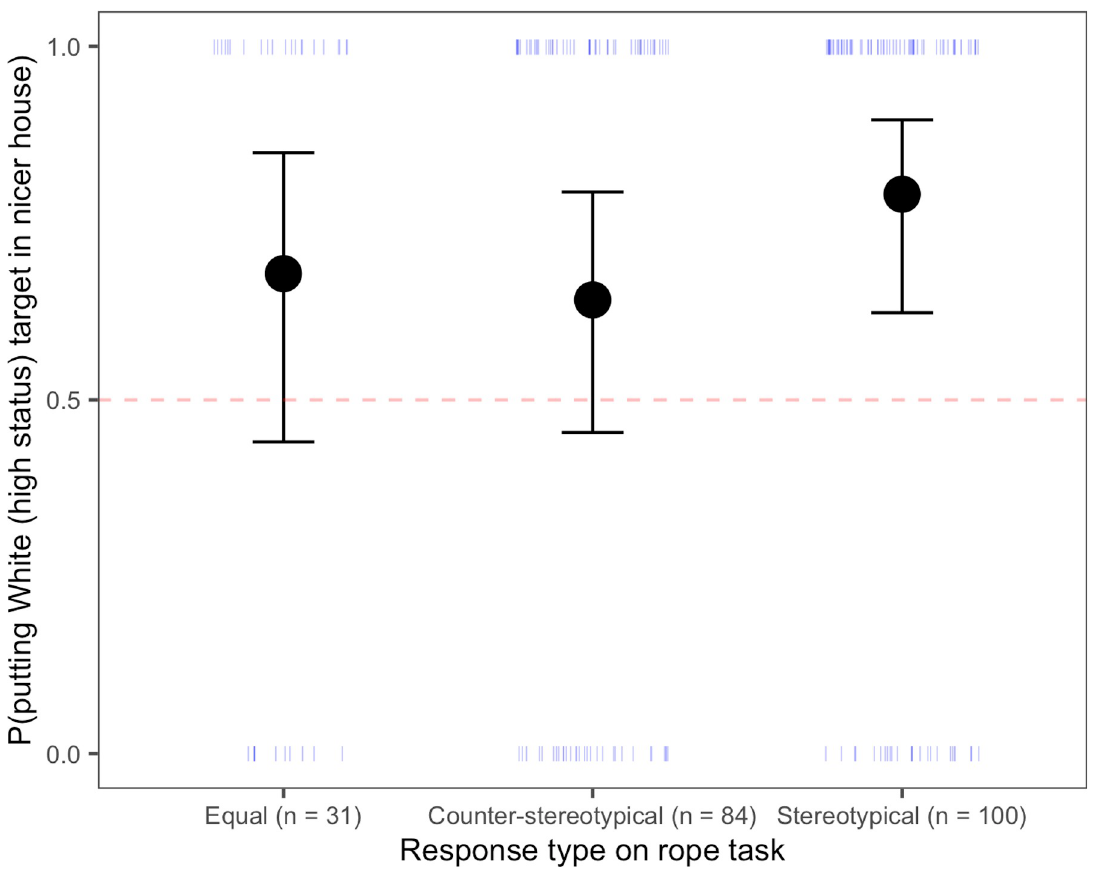
Fig 6. Probability of placing the White (high-status) child in the nicer house in the wealth-matching task, as a function of response type on the rope task. The dotted line represents chance responding. Circles represent the means for each group, and error bars represent 95% confidence intervals around the means; dashes represent individual